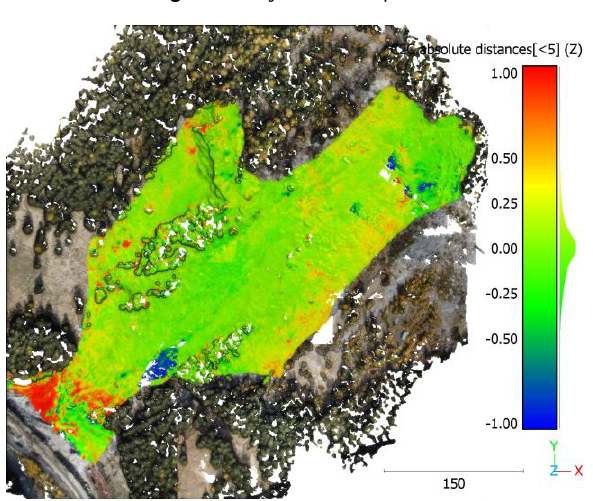
Figure 7. July 2021 orthophoto. Figure 8. October 2021 orthophoto.